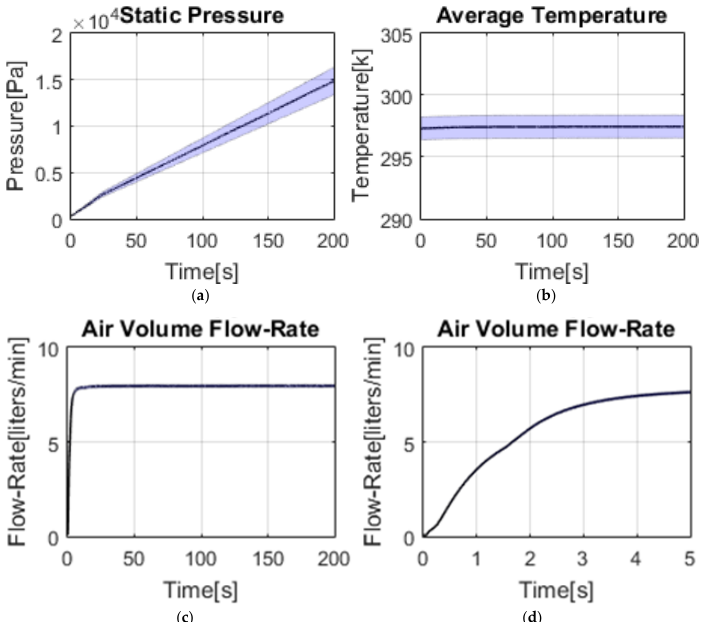
Figure 7. ( a ) Description of the pressure increase inside STARDUST-U during the air flow inlet at 8 L/min. ( b ) Description of the temperature variations measured during the experiment. ( c ) Description of the flow rate variation in the time. ( d ) Flow rate increase in the early stage from the accident experimental simulation.